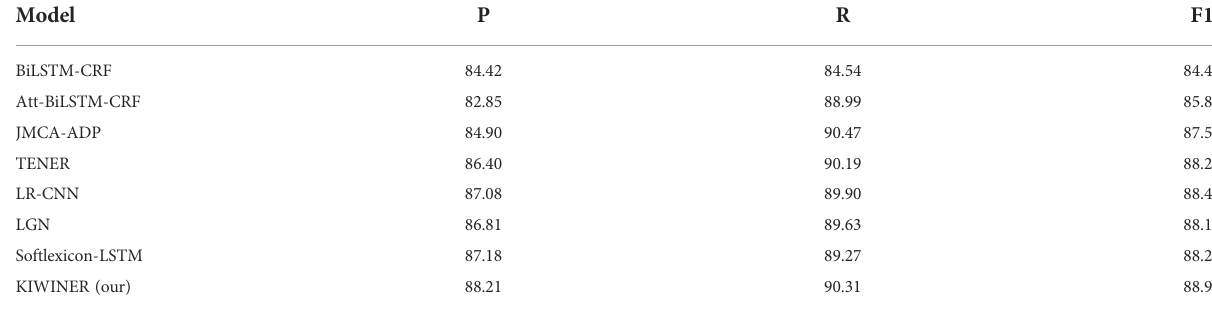
TABLE 4 Results of each model on